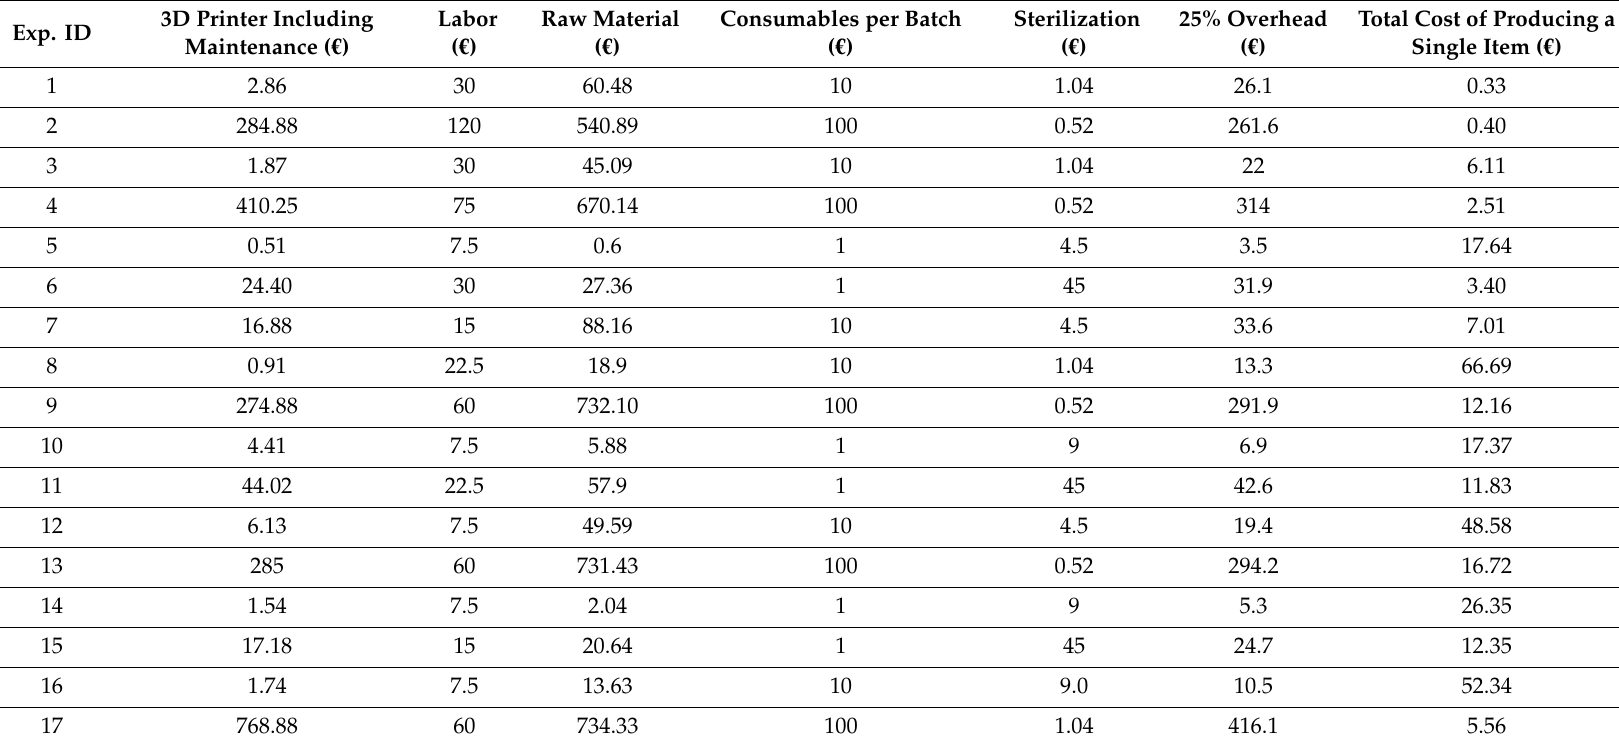
Table 7. The cost analysis of medical